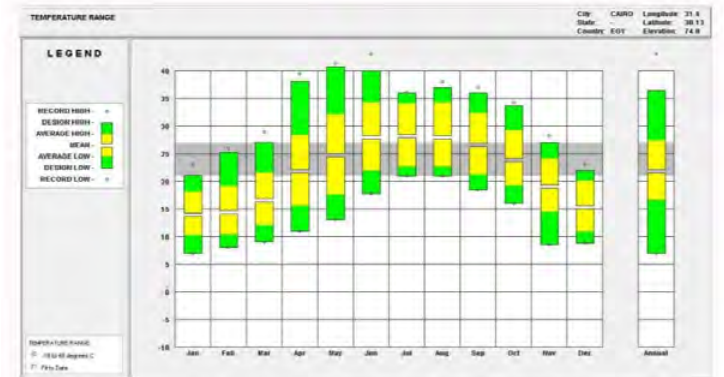
Figure 5. Climate profile of the 6 th of October city using the climate (consultant5.5) (10)